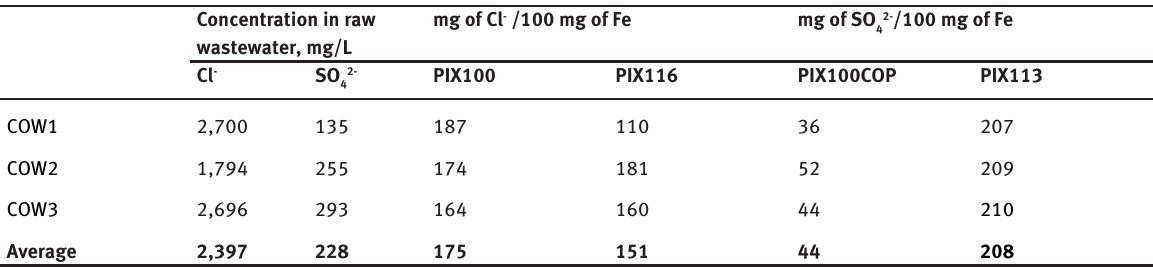
Table 4: Effect of coagulant addition on wastewater